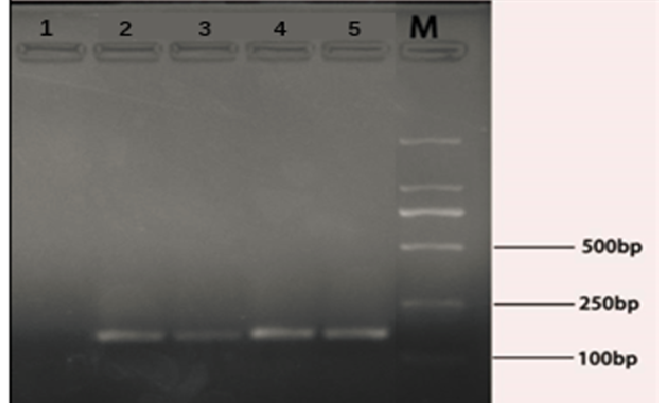
Figure 1. Amplification results of the Escherichia coli O157:H7 rfbE gene. Lane 1: ultrapure sterile water replaced the DNA template as a negative control. The lane 2, 3, 4 and 5 were four parallel samples of target gene amplification. Lane M: DL2000 DNA